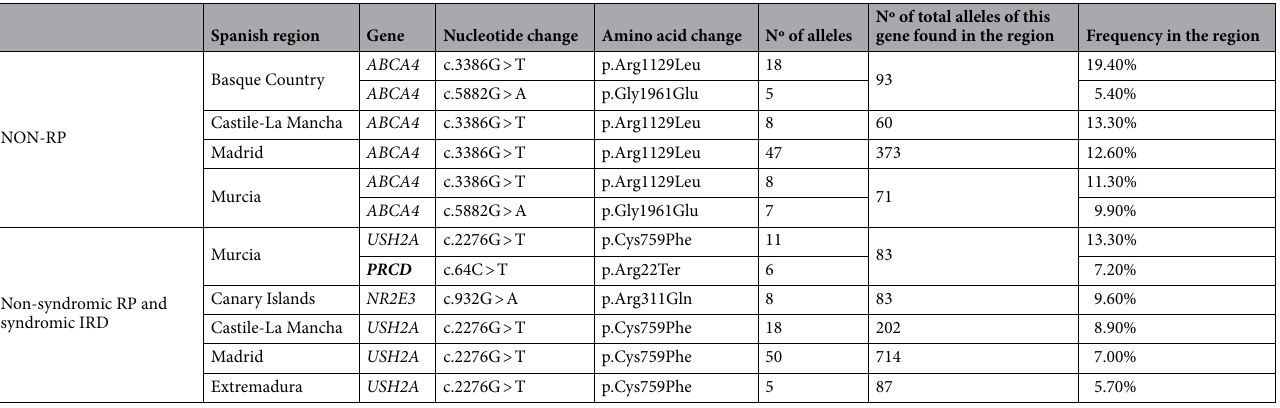
Table 1. Variants detected in > 5% of NON-RP, RP and syndromic IRD by Spanish regions. Regions with variants detected below this percentage are not represented in the table, and neither are regions with less than 50 mutated alleles in total or variants that were presented less than 5 times. In bold the variant which not appeared as one of the most frequent variants in Supplementary Table